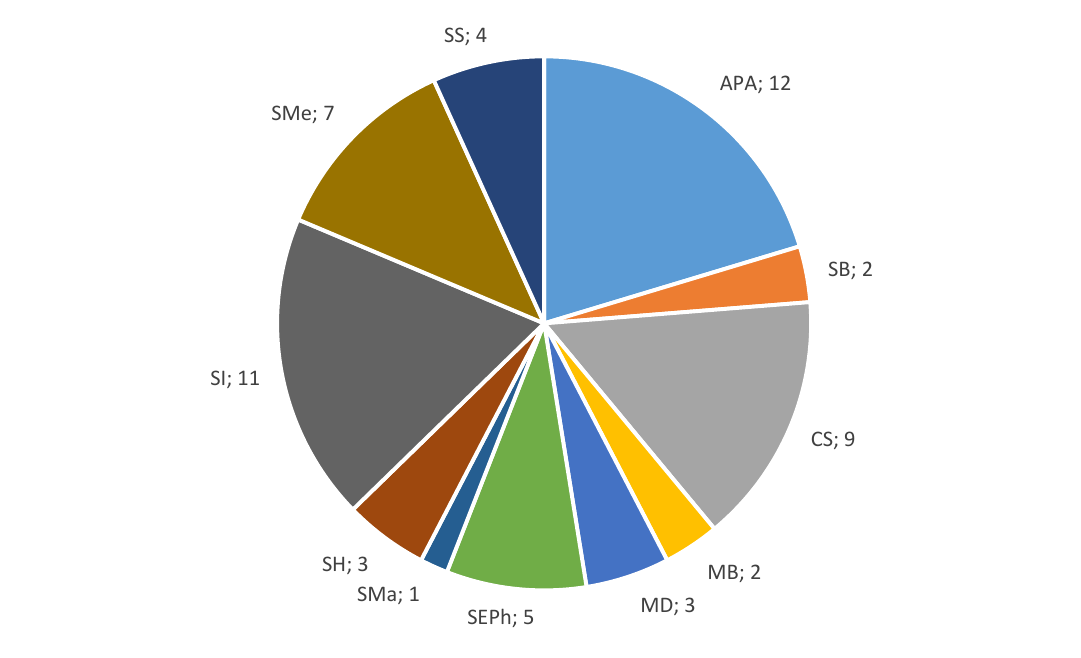
Figure 4. Document classification according to the Sport Science disciplines. APA Adapted